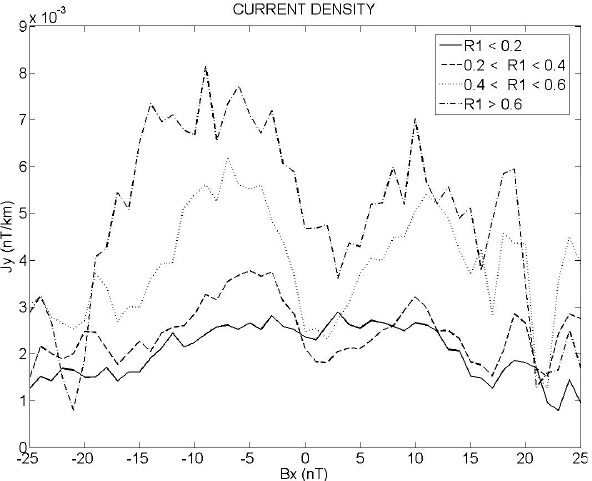
Fig. 8. The electric current density distributions j y (B x ) for T || <T ⊥ (solid line) and T || >T ⊥ (dashed line).